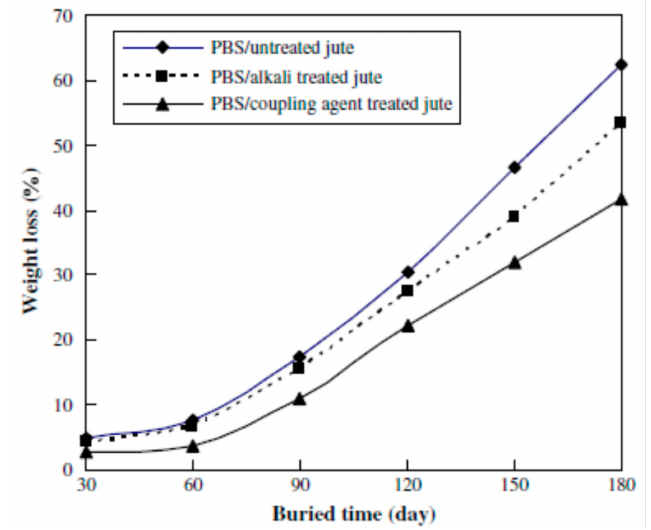
Figure 21. Weight loss of PBS/jute fiber composites consisting of untreated, alkali- and coupling agent-treated jute fibers [103]. Elsevier.